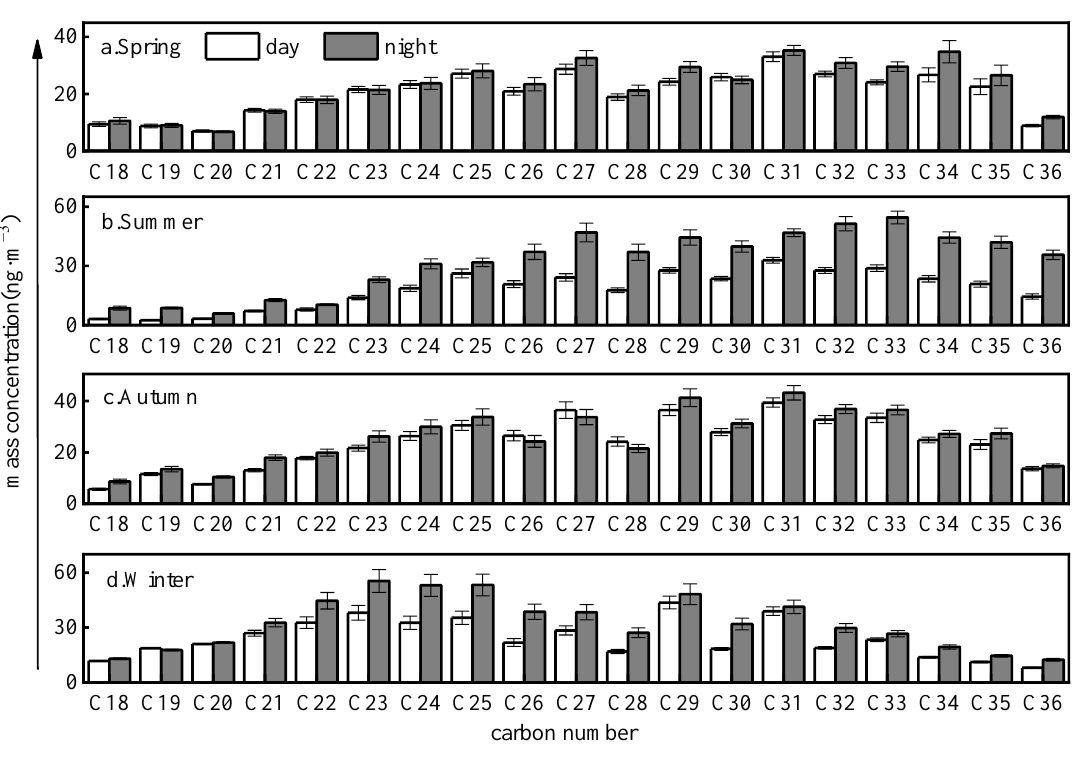
Figure 1. Seasonal and daily variations of n-alkanes mass concentrations (error bars represent min.–max. concentrations).